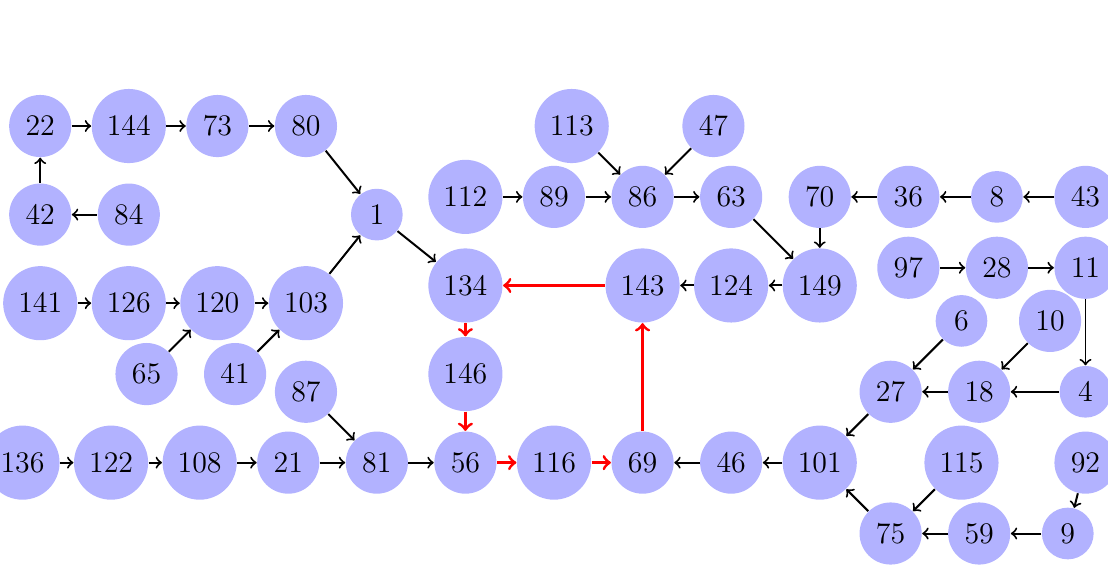
Figure 8: The unique component containing cycle of length 6